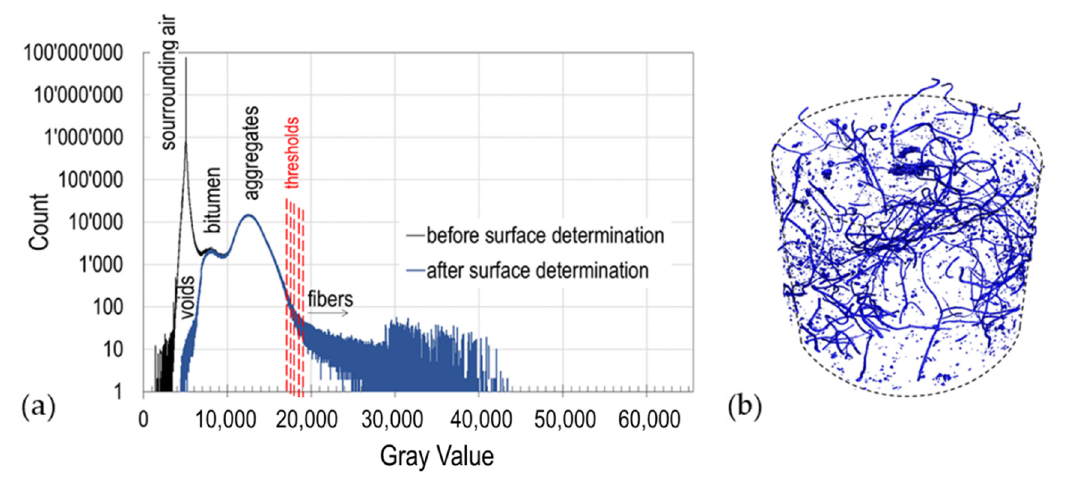
Figure 5. ( a ) Histogram of grayscale distribution of the images of the 1.5% specimen before and after surface determination showing the materials peaks and the threshold selected. ( b ) View of the inclusions after segmentation (no filter), 1.5% fiber content.